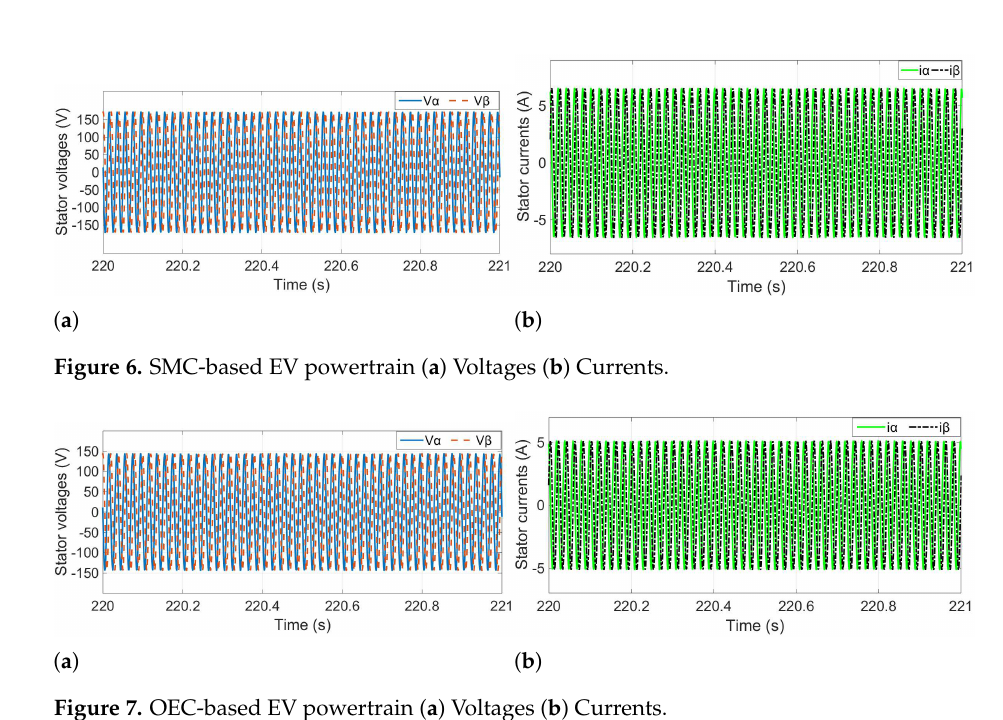
Figure 7. OEC-based EV powertrain ( a ) Voltages ( b ) Currents.